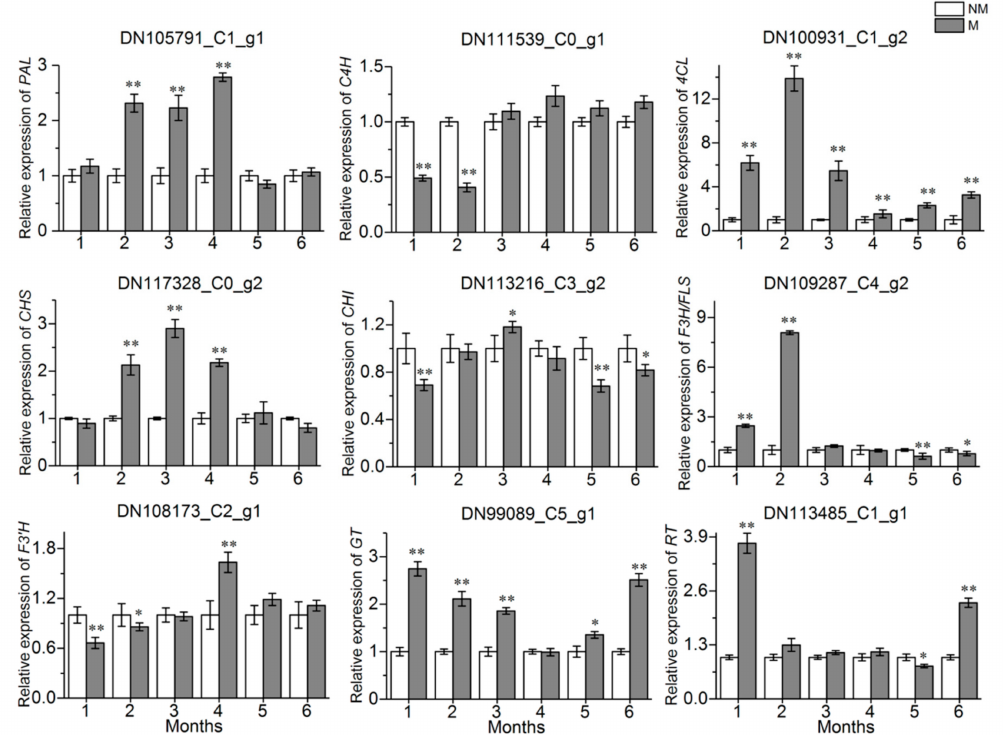
Figure 9. Expression levels of flavonoid biosynthetic genes in the M and NM growth 0 month to 6 months. M and NM represent the mycorrhizal A. roxburghii and non-mycorrhizal A. roxburghii , respectively. DNxx_Cx_g1 represents the ID of gene. The x-axis indicates the relative expression level of the genes. Each value is the mean of three replicates, and error bars indicate standard deviations. Statistical analysis of the data was performed by independent samples t -test using the SPSS 22.0 software (IBM, Chicago, IL, USA). * and ** above the columns are significantly di ff erent at p ≤ 0.05 and p ≤ 0.01,